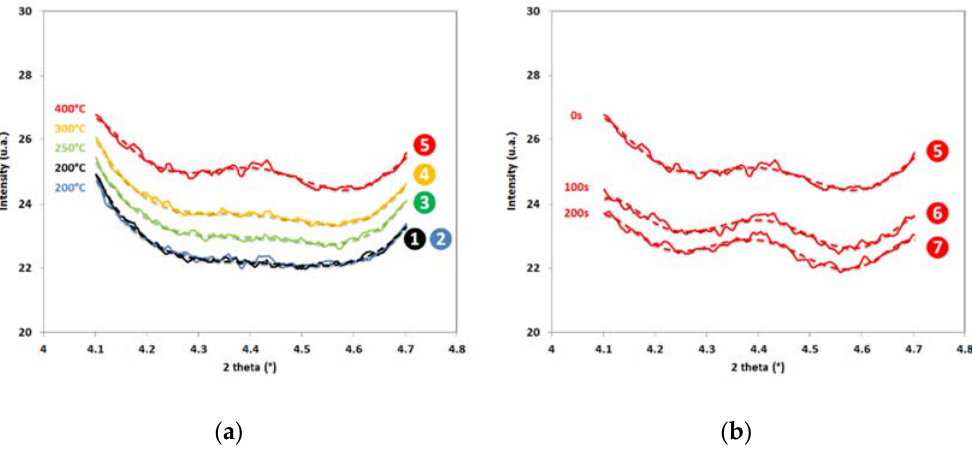
Figure 6. Experimental 1D diffractograms in a reduced angular windows corresponding to the second minor diffraction peak in Figure 4b obtained at different steps of Q&P treatment ( a ) points 1 to 5 according to Figure 1, i.e., after quenching and during reheating ( b ) points 5 to 7 according to Figure 1, i.e., during partitioning.